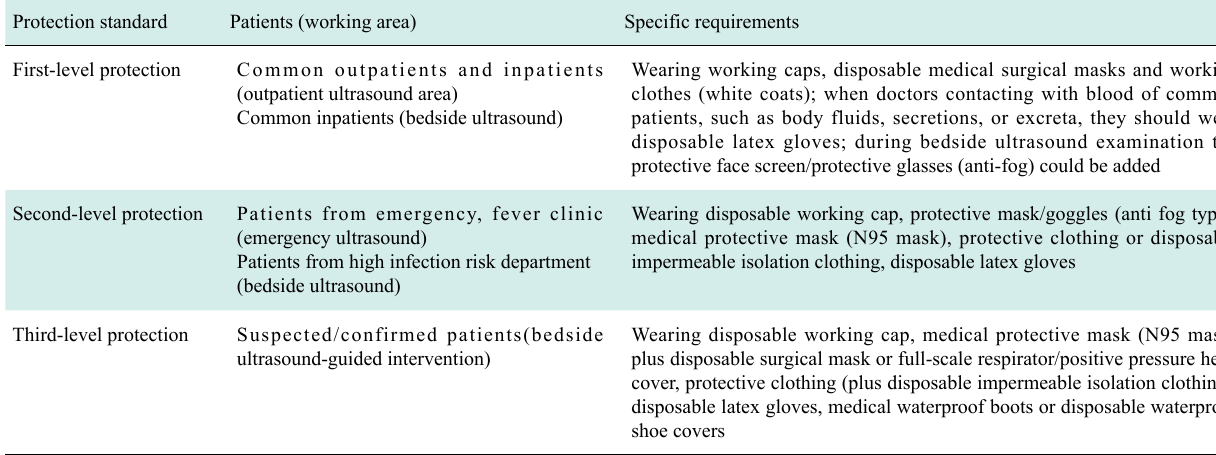
Table 2 Protective standards and requirements in different working areas facing different patients